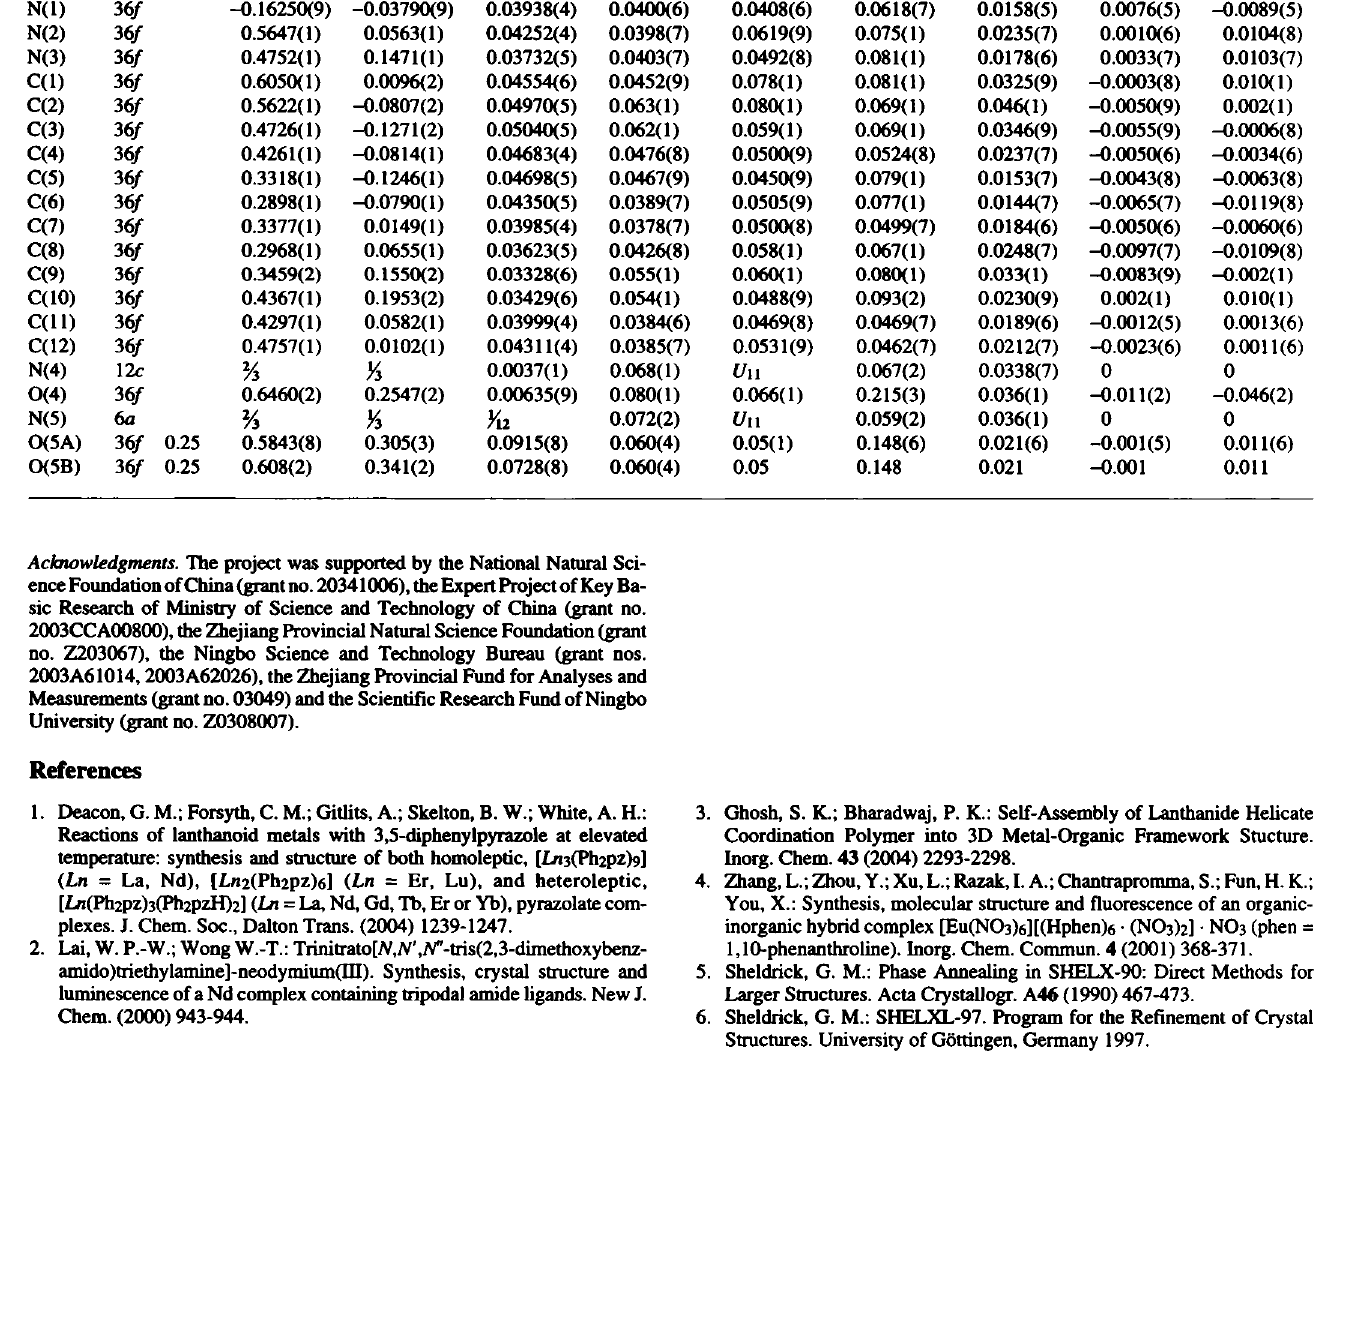
Table 3. Atomic coordinates and displacement parameters (in A 2